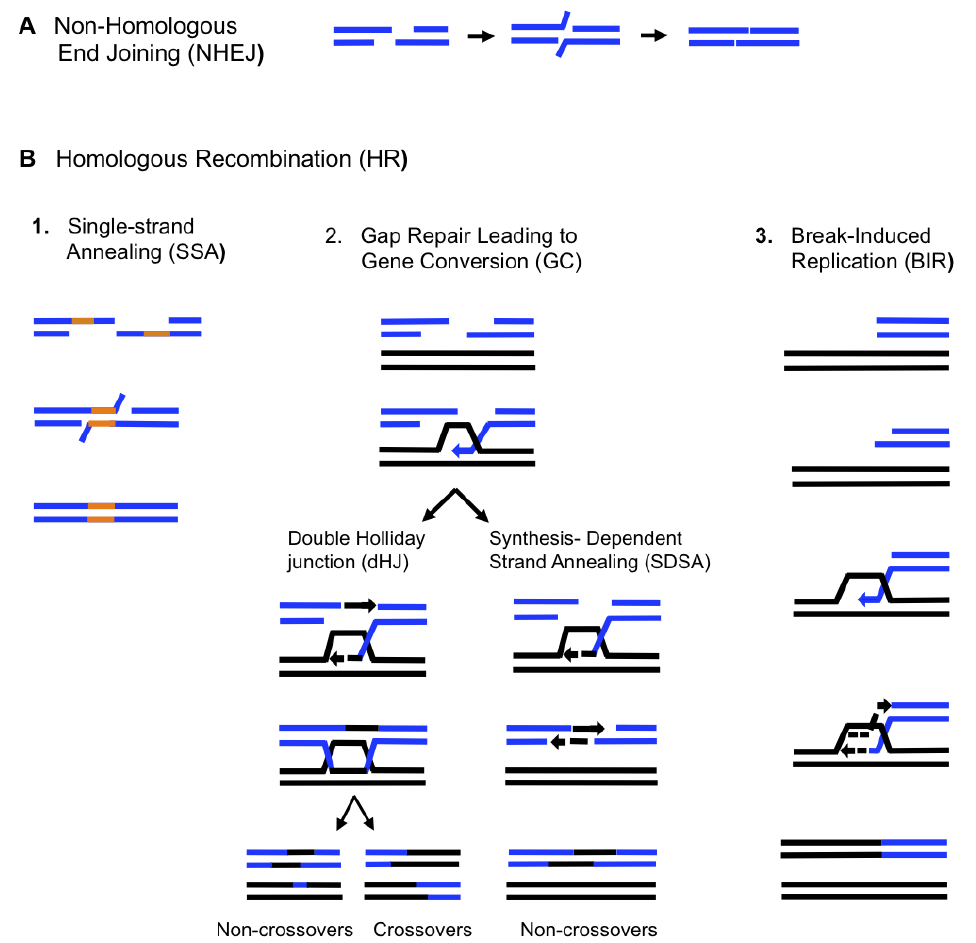
Figure 1. Mechanisms of double-strand DNA breaks (DSB) repair. (A). Non-homologous end joining (NHEJ) involves re-ligation of broken DNA ends resulting in small deletions or insertions (B). Repair by homologous recombination (HR) starts with resection of DSB ends in a 5’ to 3’ direction and requires the involvement of long homologous